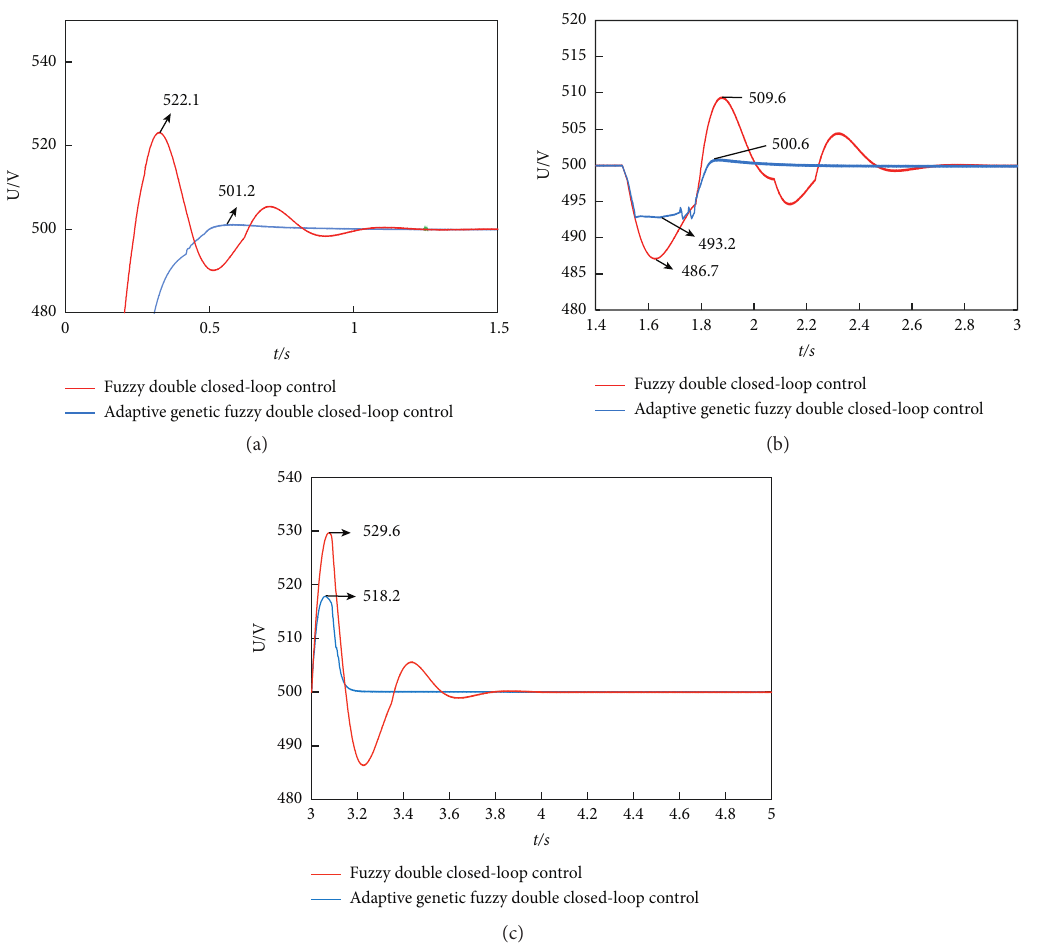
Figure 8: Voltage comparison of microgrid 1 bus. (a) Initial power-on. (b) Sudden increase of load. (c) A sudden drop in load.